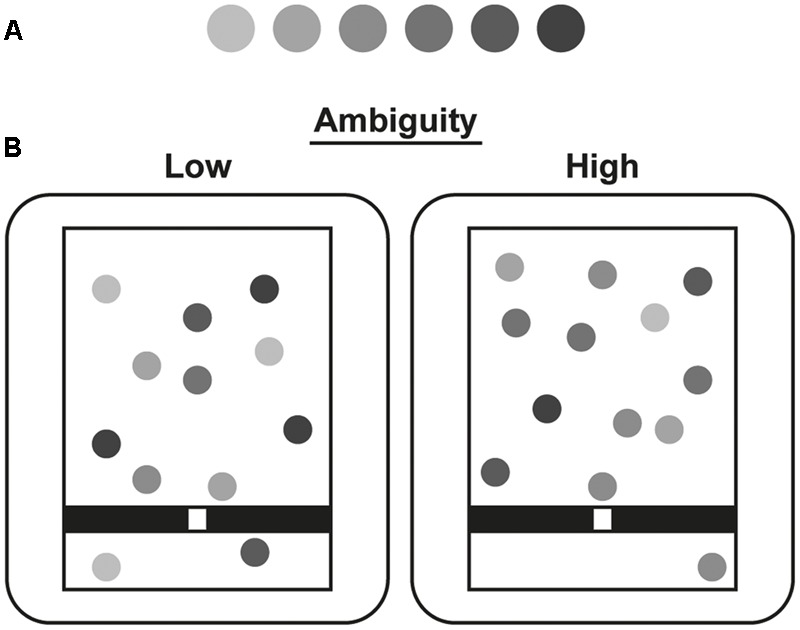
Schematic of stimuli in Experiment 2. (A) The six graded shades of gray used. The first three stimuli were classed as light gray, whereas the last three were classed as dark gray. (B) The two ambiguity conditions, which differed in their proportions of extreme and ambiguous gray shades. Stimulus size and colors have been adapted.